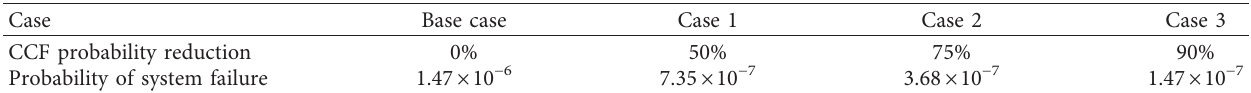
Table 9: Probability of the system failure on demand with the use of diversity